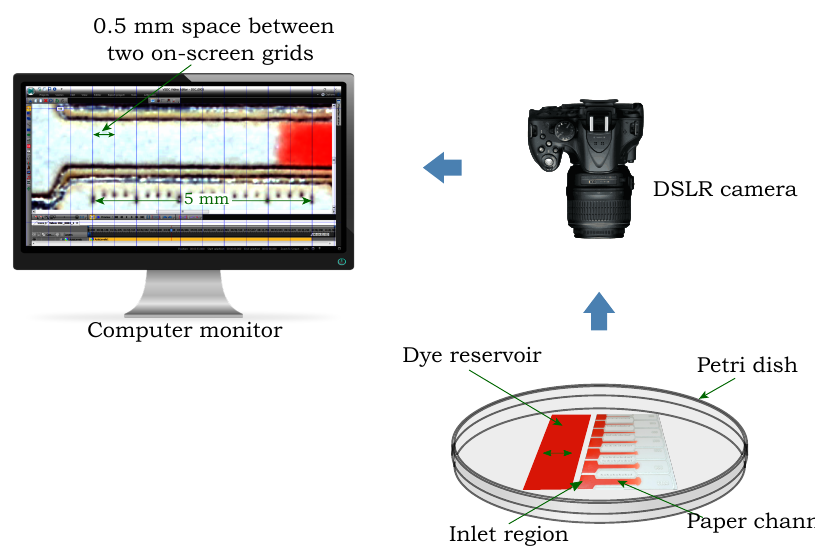
Figure 2. Schematic of the experimental procedure for measuring the flow speeds of dye solution through varying channel widths.